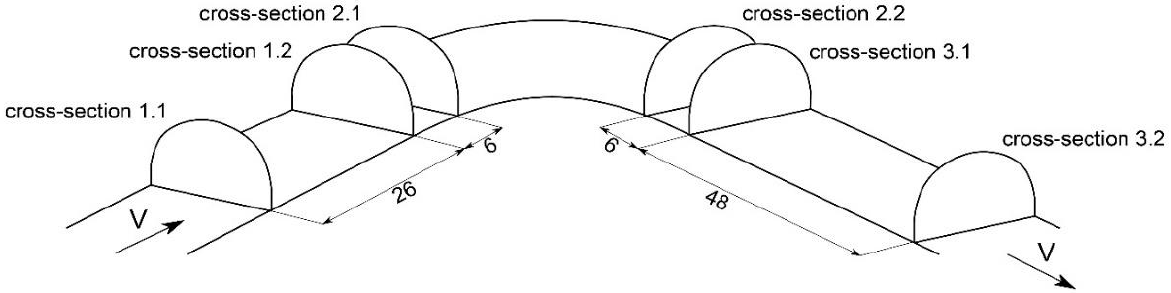
Figure 4. Measurement cross-sections.